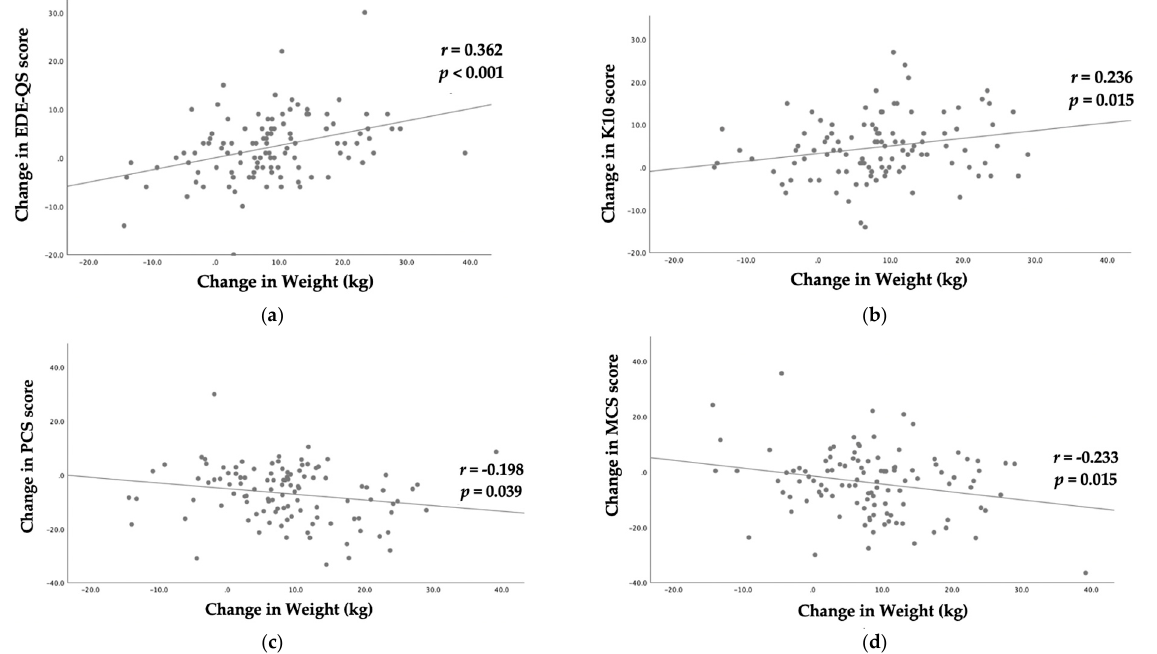
Figure 2. Scatter plots of change in: ( a ) Eating Disorder Examination Questionnaire Short (EDE-QS) score; ( b ) Kessler Psychological Distress Scale (K10) score; ( c ) Physical Component Summary (PCS) score; and ( d ) Mental Component Summary (MCS) score, against change in weight (kg) with fitted linear regression lines.